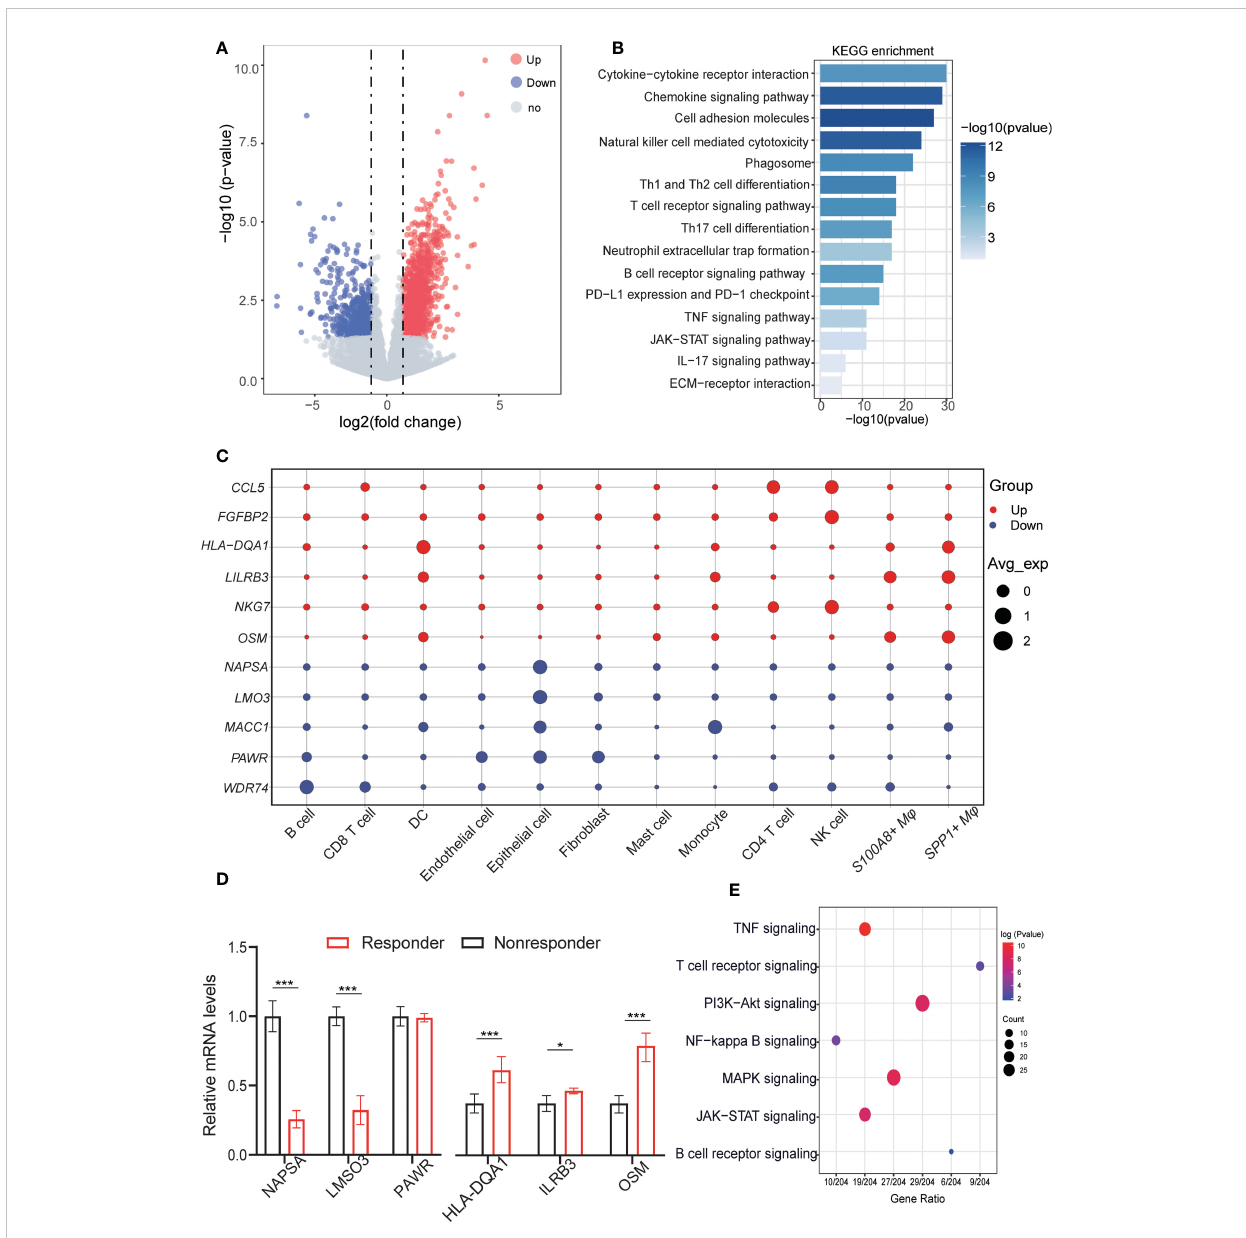
FIGURE 2 Aberrant gene expression pro fi les in cell type-speci fi c manners in LUAD with anti-PD-L1 treatment. (A) Volcano plot shows the differentially expressed genes (DEGs) between responders and nonresponders analyzed by bulk RNA-seq from datasets. Genes upregulated or downregulated by more than 2-fold are shown in red and blue, respectively. 1488 upregulated genes and 1575 downregulated genes. (B) Bar plots displaying the KEGG enrichment of up- or downregulated genes in LUAD patients (responders vs. nonresponders). Fisher ’ s exact tests (two-sided) were performed. A p value < 0.05 was de fi ned as statistically signi fi cant. (C) Dot plots depicting how the relative expression of particular genes varies at all cell type levels (responders vs. nonresponders). The size displays the values for expression in the cell types, and colors are marked as up- or downregulation in the bulk cohort (red, increased; blue, decreased). (D) QRT-PCR validation the representative genes were highly expressed in celltype for responders and nonresponders. (E) Dot plot showing the results of KEGG pathways enrichment analyses for the DEGs of responder vs. nonresponder at the cellular level. *p < 0.05; ***p <